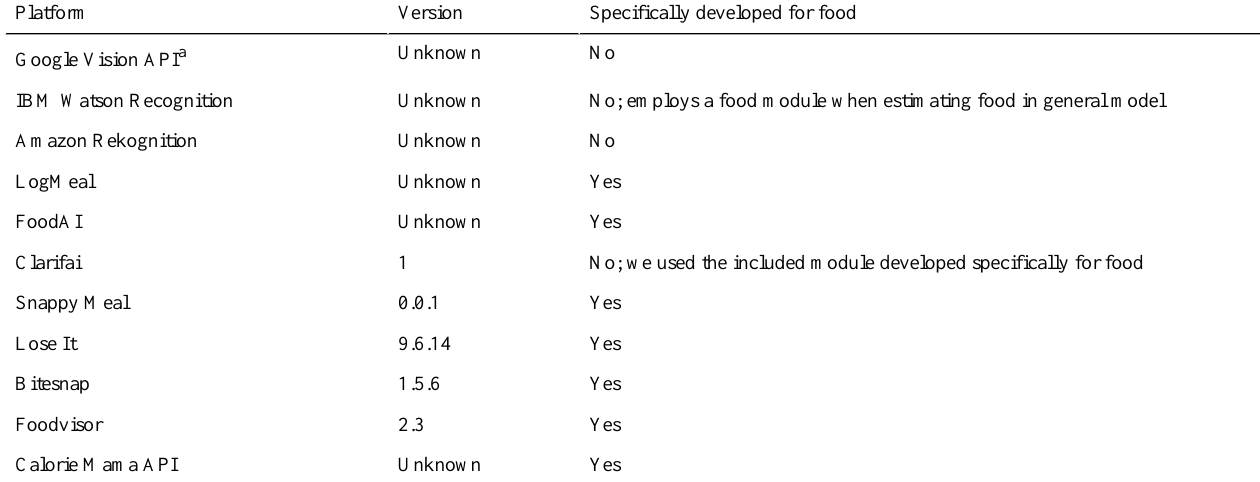
Table 1. Selected platforms identifying food